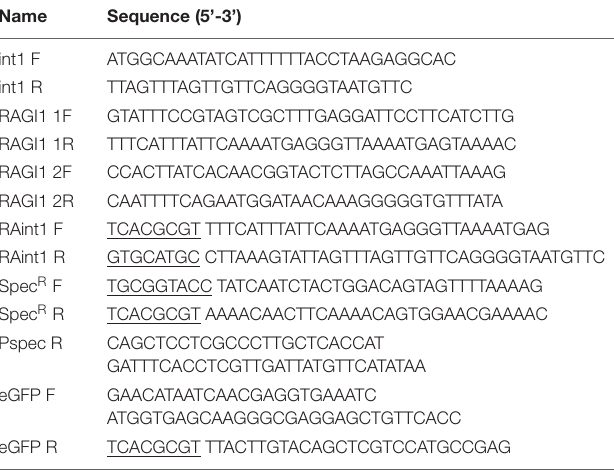
TABLE 2 | Primers used in this